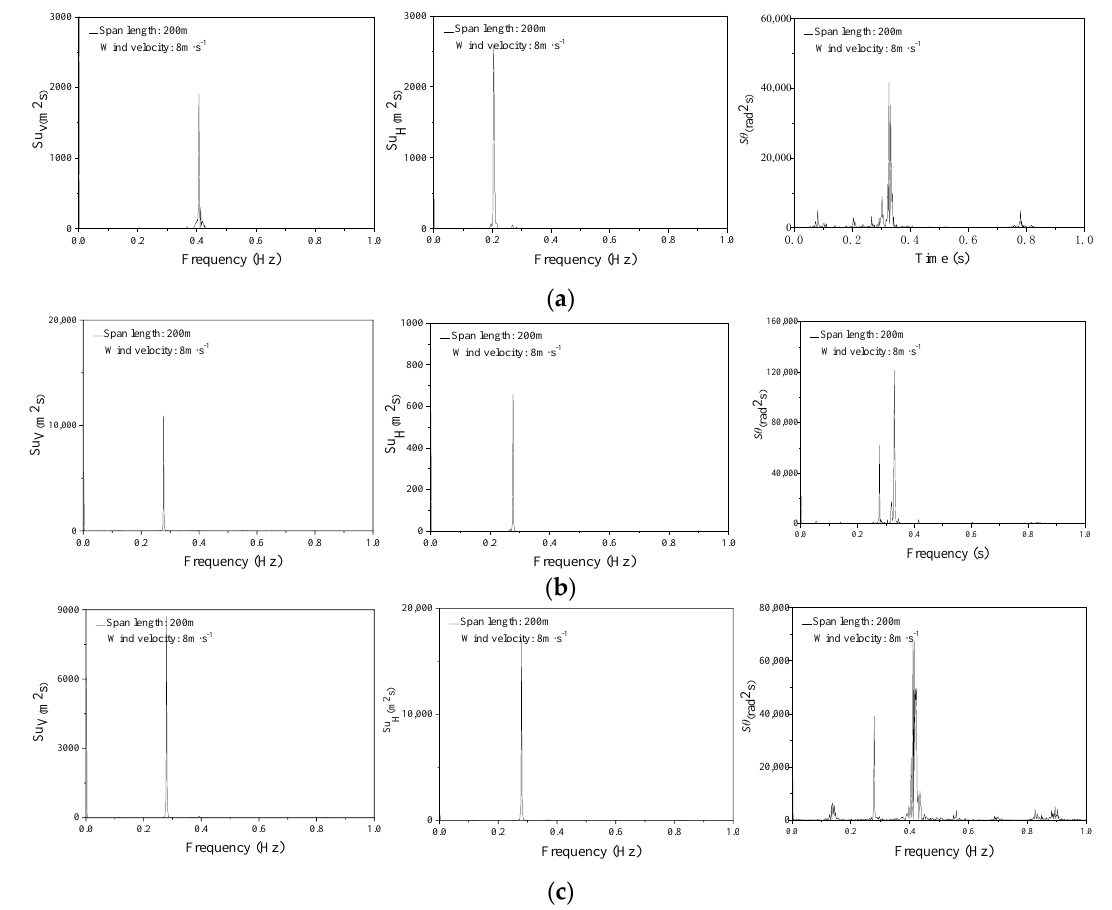
Figure 4. Midpoint spectrum diagram of each span of conductor under wind velocity of 8 m/s with span length: 200 m: ( a ) Spectrum diagram of the first span conductor; ( b ) Spectrum diagram of the second span conductor; ( c ) Spectrum diagram of the third span conductor.